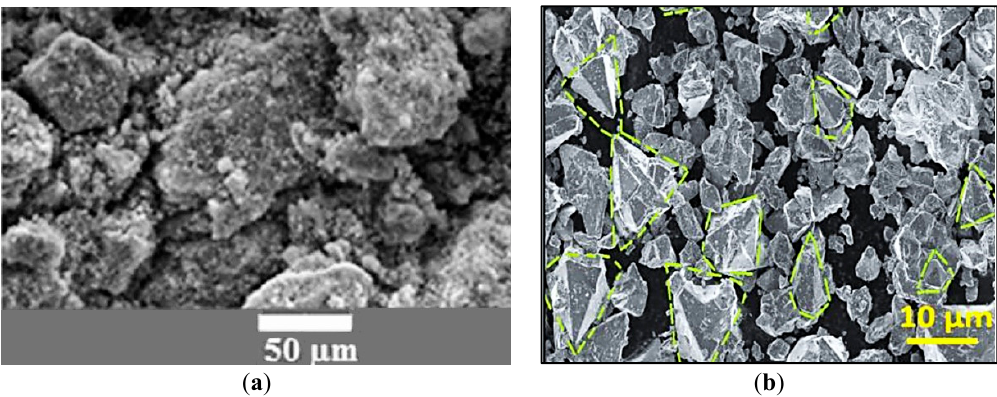
Figure 10. SEM images of ( a ) Mg doped ZnO-Al 2 O 3 photocatalyst [43] and ( b ) cone-like ZnO shape [82].